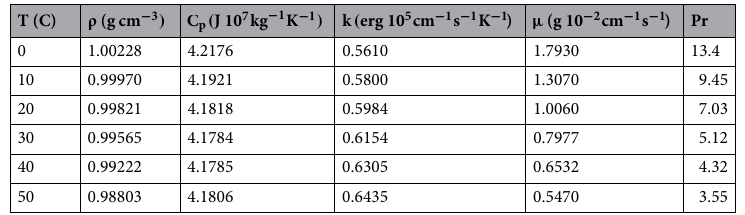
Table 1. Water properties vs. temperatures 44,45